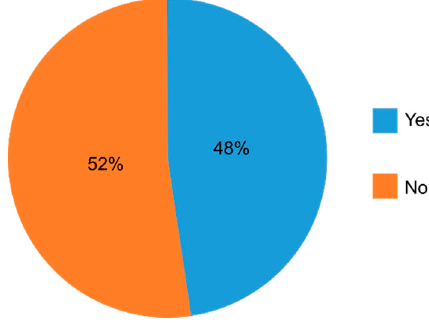
Figure 11. The consumption of alcohol by construction workers (own elaboration).